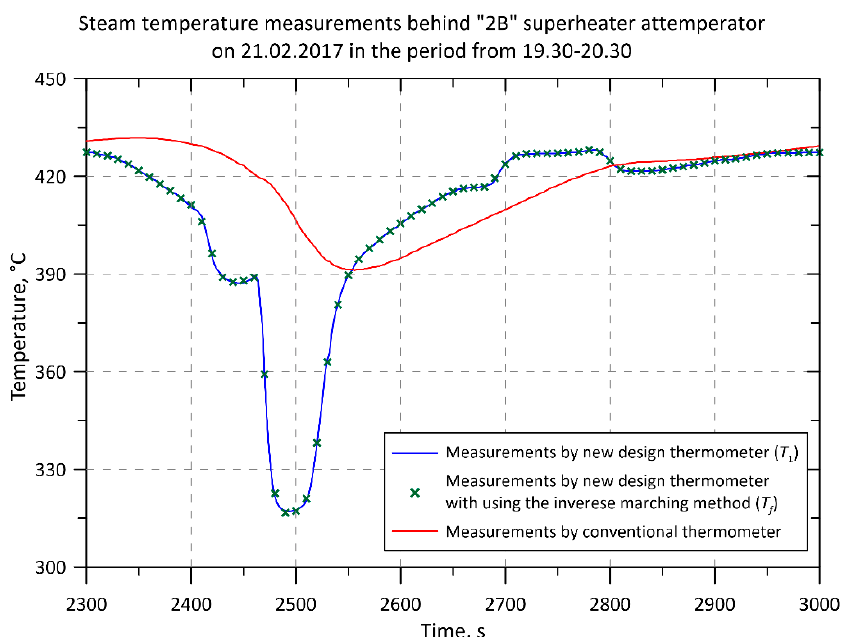
Figure 8. Comparison of superheated steam temperature downstream of the second superheater attemperator measured on side “B” in the K11 boiler by conventional and new design thermometers (selected fragment).